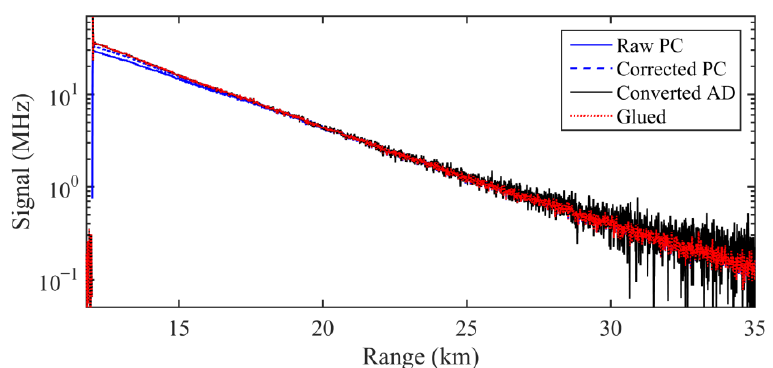
Figure 7. The signal profiles of the edge 1 channel: the raw PC signal, the PC signal with dead-time correction, the converted AD signal that is regarded as the “actual PC signal” and the glued signal.